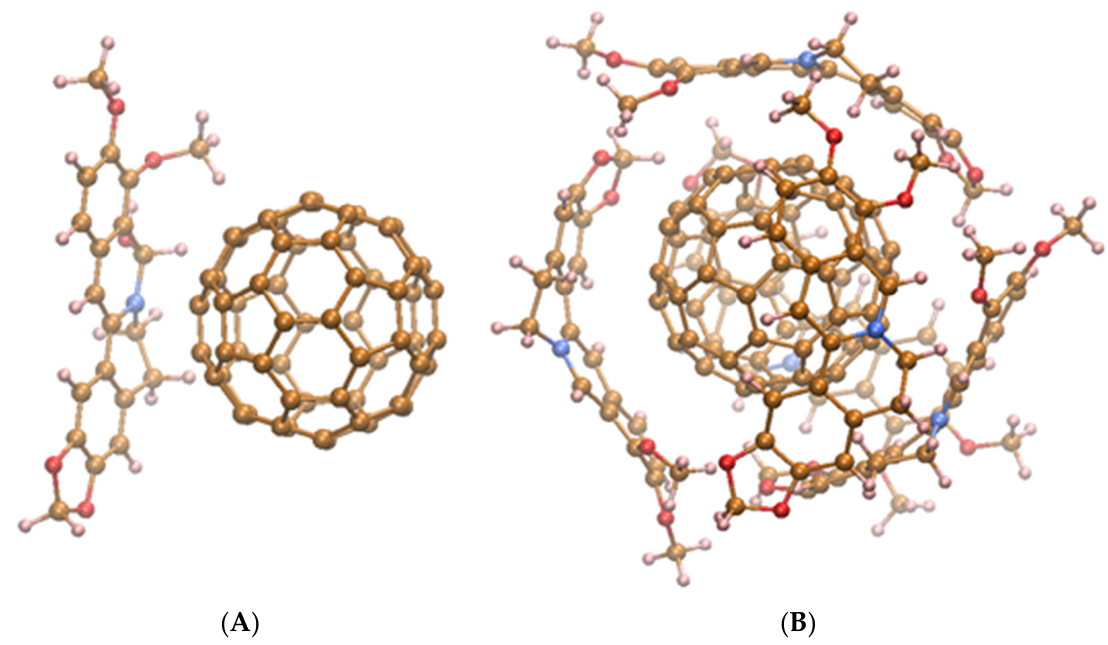
Figure 1. The energy-minimized structure of nanocomplexes formed at C 60 binding with one ( A ) or five ( B ) Ber molecules.